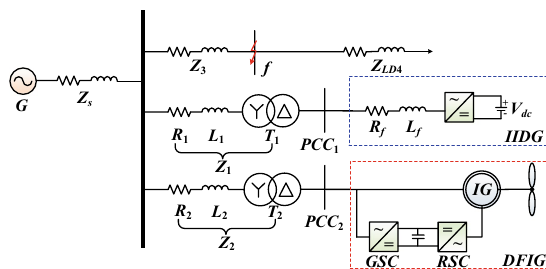
Fig. 4 Equivalent model of the distribution network with